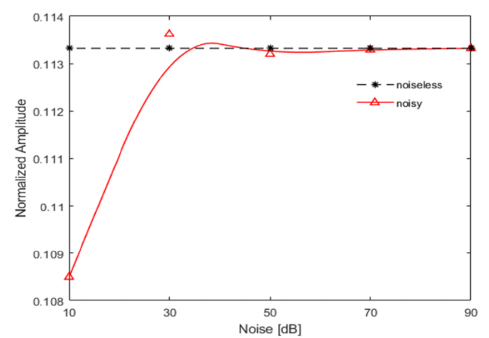
Figure 13. Variation trend of the second harmonic amplitude with signal-to-noise ratio (SNR).